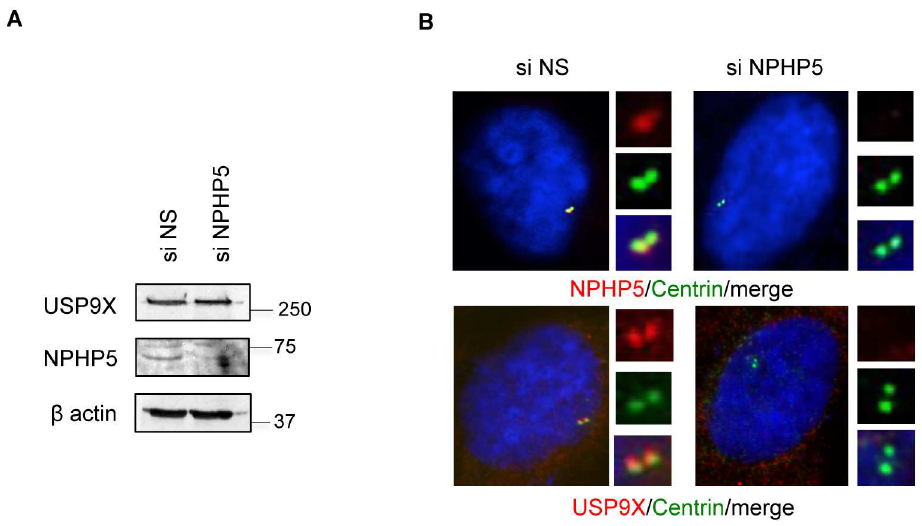
Fig 5. NPHP5 recruits USP9X to the centrosome. A) HEK293 cells were transfected with control (NS) and NPHP5 siRNA. Lysates were Western blotted with the indicatedantibodies. β actin was used as a loading control. B) RPE-1 cells transfected with control (NS) and NPHP5 siRNA were stainedwith anti-NPHP5 or anti- USP9X (red) and anti-centrin (green) antibodies. DNA was stainedwith DAPI